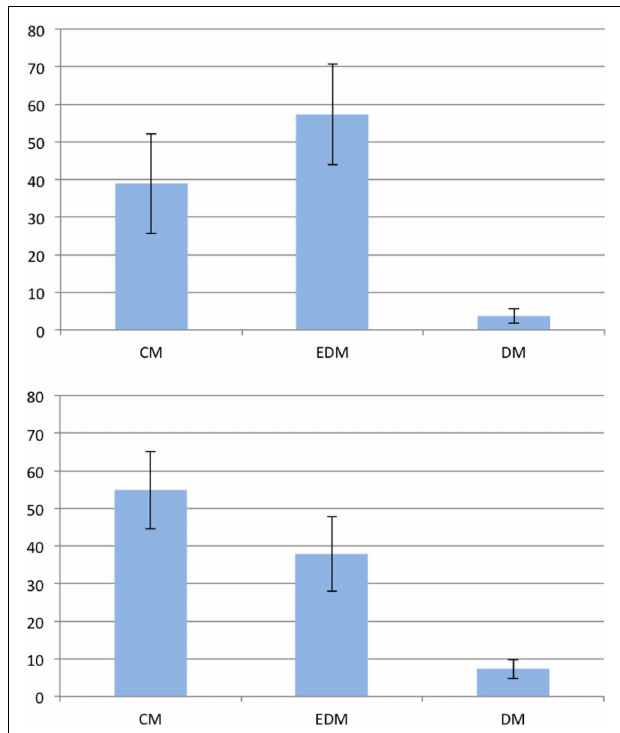
FIGURE 7 | Preferences of the 45˚ problems in the second experiment. The vertical axis represents the frequency of the given answer.Top: non-eye-movers; bottom: eye-movers. Error bars show the standard error of the mean. EDM, equal-distance model; CM, cardinal model; DM, distorted